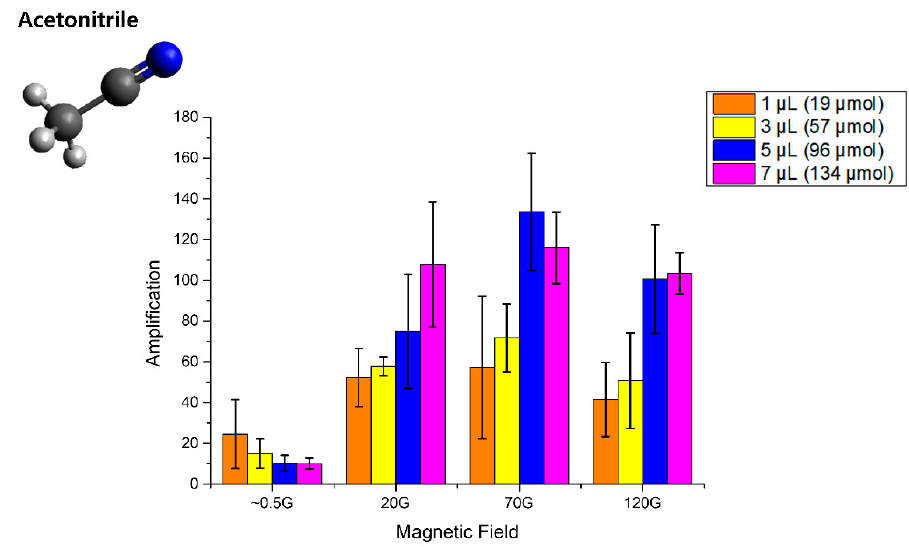
Figure 2. Amplification factors according to different magnetic fields for different amounts of acetonitrile in the solvent (MeOH- d 4 ).